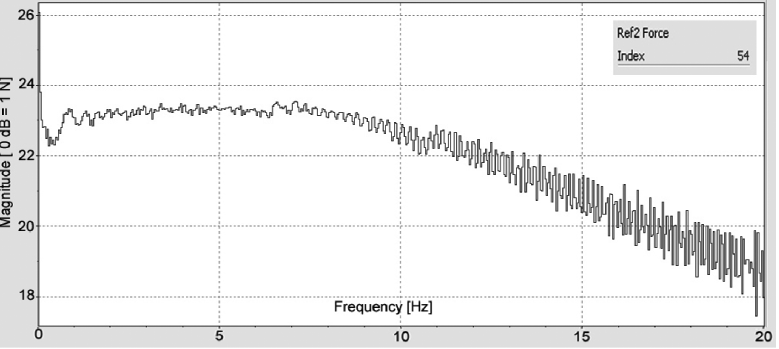
Fig. 6. Measured force applied to the joist.